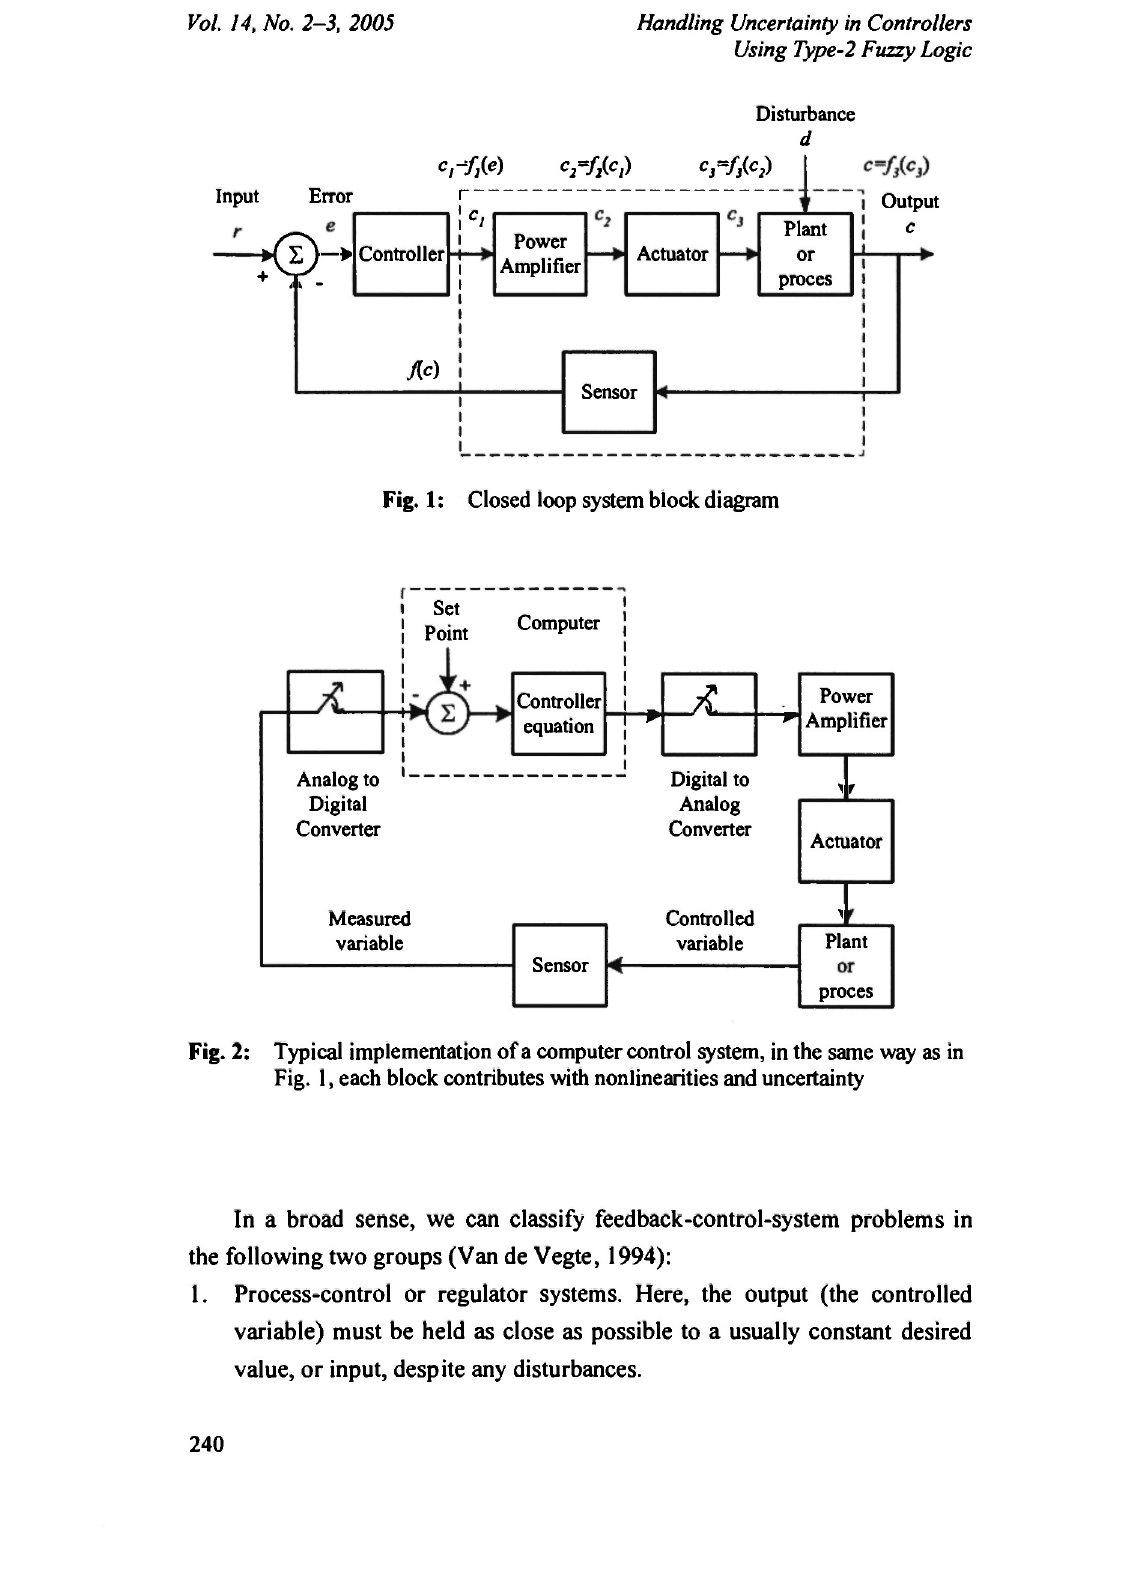
Fig. 1: Closed loop system block diagram